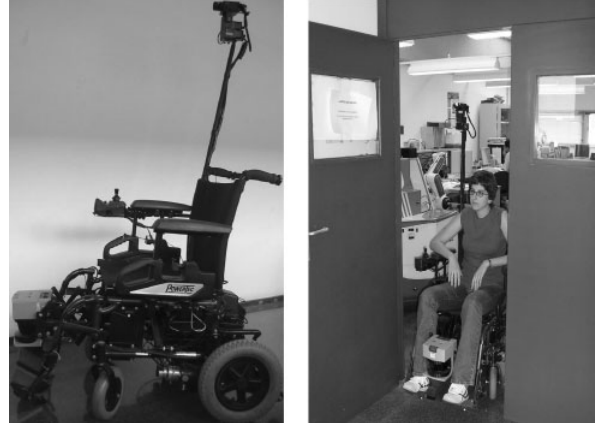
Figure 4 Two views of the SENA robotic wheelchair